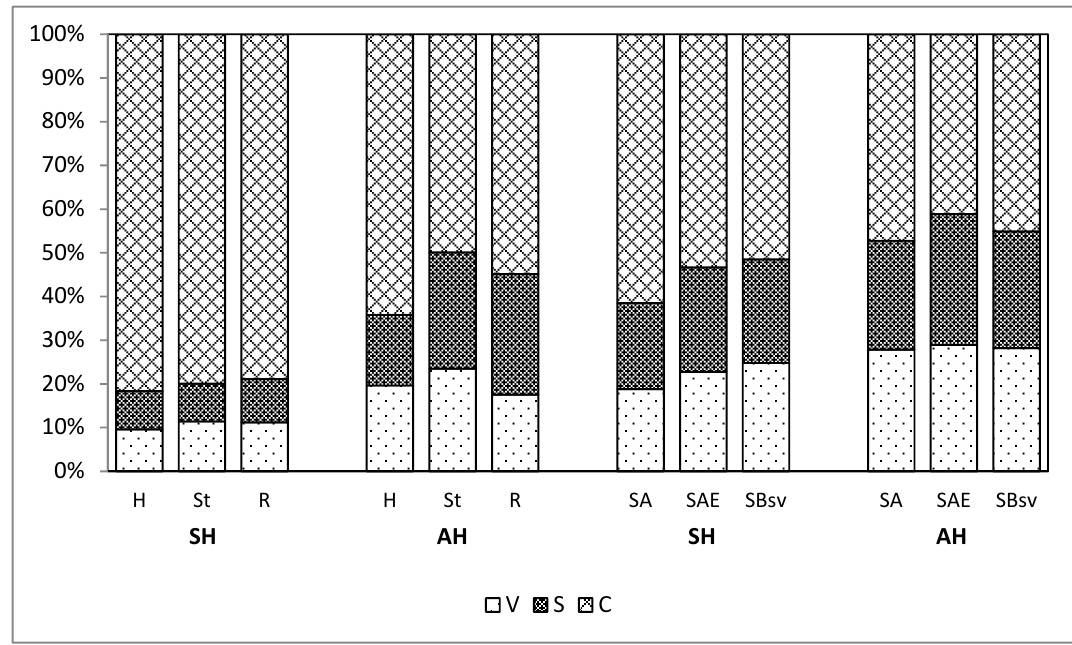
Figure 4. Share of vanillyl (V), syringyl (S), and cinnamyl (C) compounds in V + S + C, following acid hydrolysis ( AH ) and both hydrolyses ( SH , acid and alkaline).